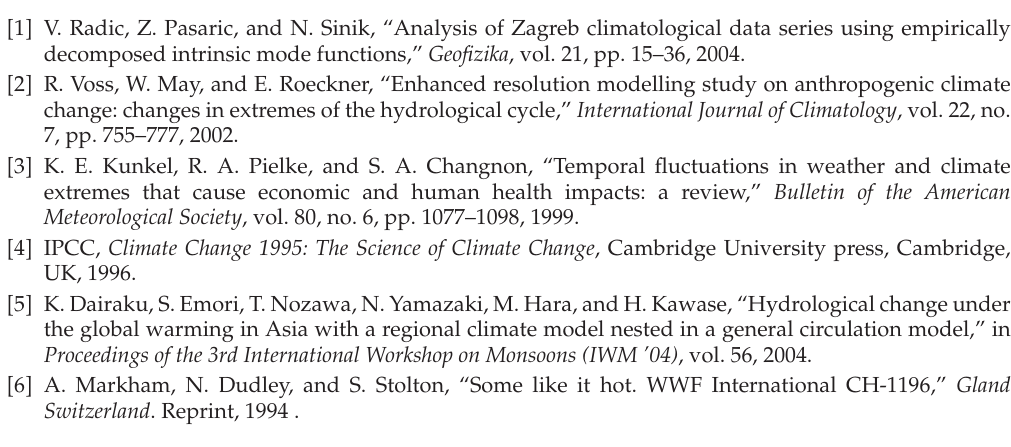
numbers of IMFs for one climate signal and the corresponding fGn. Hence it performs better and more appropriate than the ordinary EMD for the analysis of climate